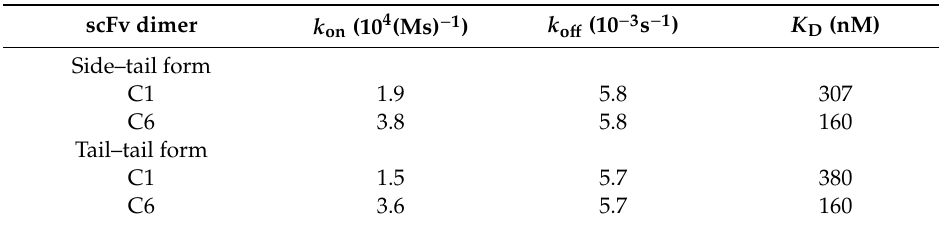
Table 5. Surface plasmon resonance measurement for the binding a ffi nity of chemEx3 dimers with respect to